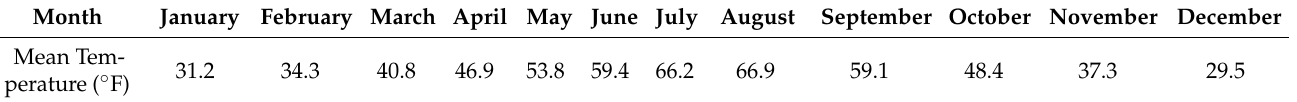
Table 2. Averaged monthly temperatures, Moscow Idaho,